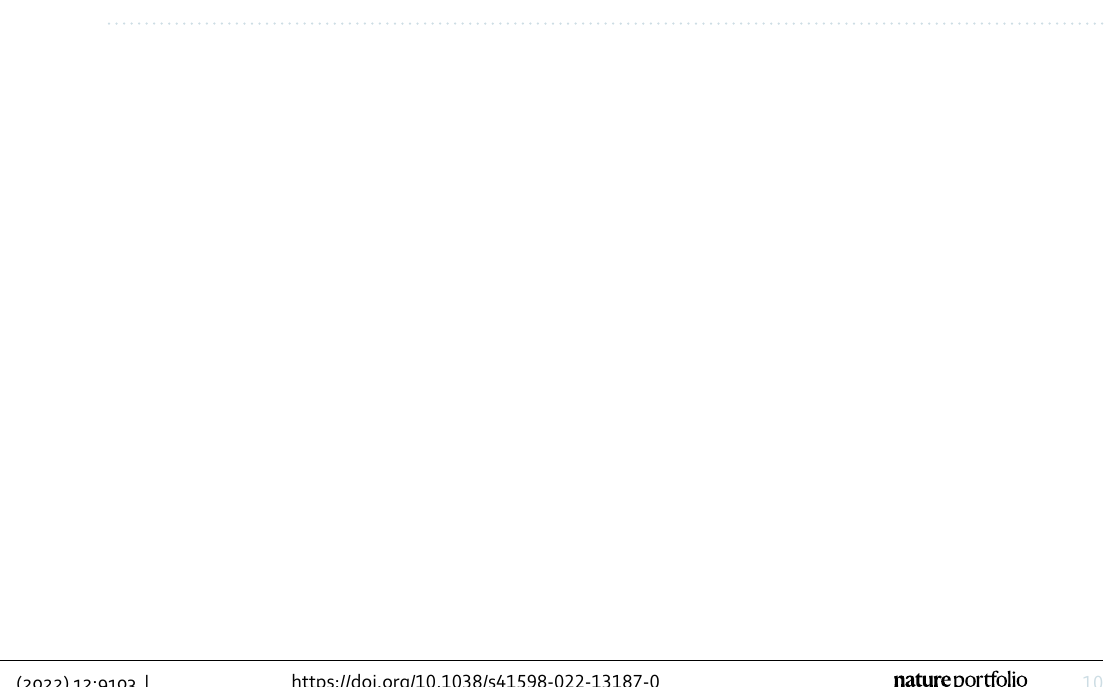
Figure 9. Detailed mechanism of the ZIF-8 layer formation on the surface of a titanium alloy modified with zinc